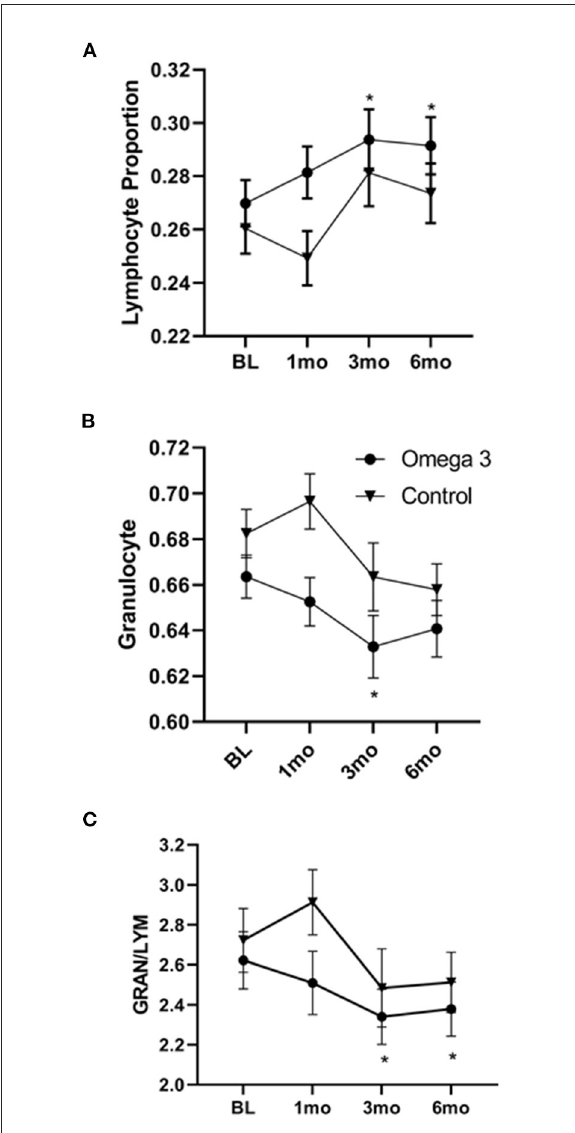
FIGURE6 Omega 3 supplements significantly increase lymphocytes and decrease granulocytes, as determined by a hematology analyzer. (A) Average lymphocyte numbers, expressed as the proportion of total white blood cells, of participants taking ( H , n = 39) and not taking (•, n = 19) omega 3 supplements at baseline, 1, 3, and 6 months. (B) Average granulocyte numbers, expressed as the proportion of total white blood cells, of participants taking ( H , n = 39) and not taking (•, n = 19) omega 3 supplements at baseline, 1, 3, and 6 months. (C) Average granulocyte/lymphocyte ratio of participants taking ( H , n = 39) and not taking (•, n = 19) omega 3 supplements at baseline, 1, 3, and 6 months. *Denotes significant ( P < 0.05) difference when compared to baseline